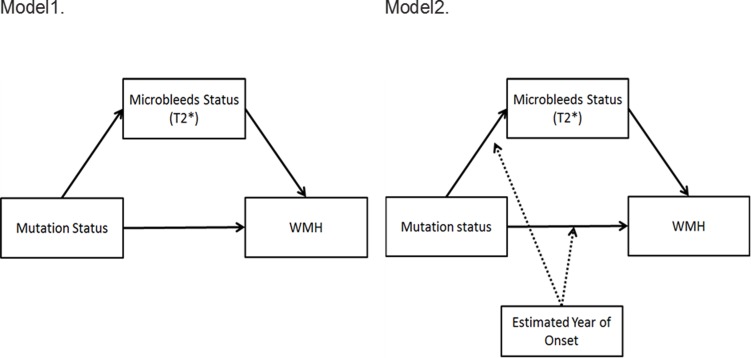
Mediation models.